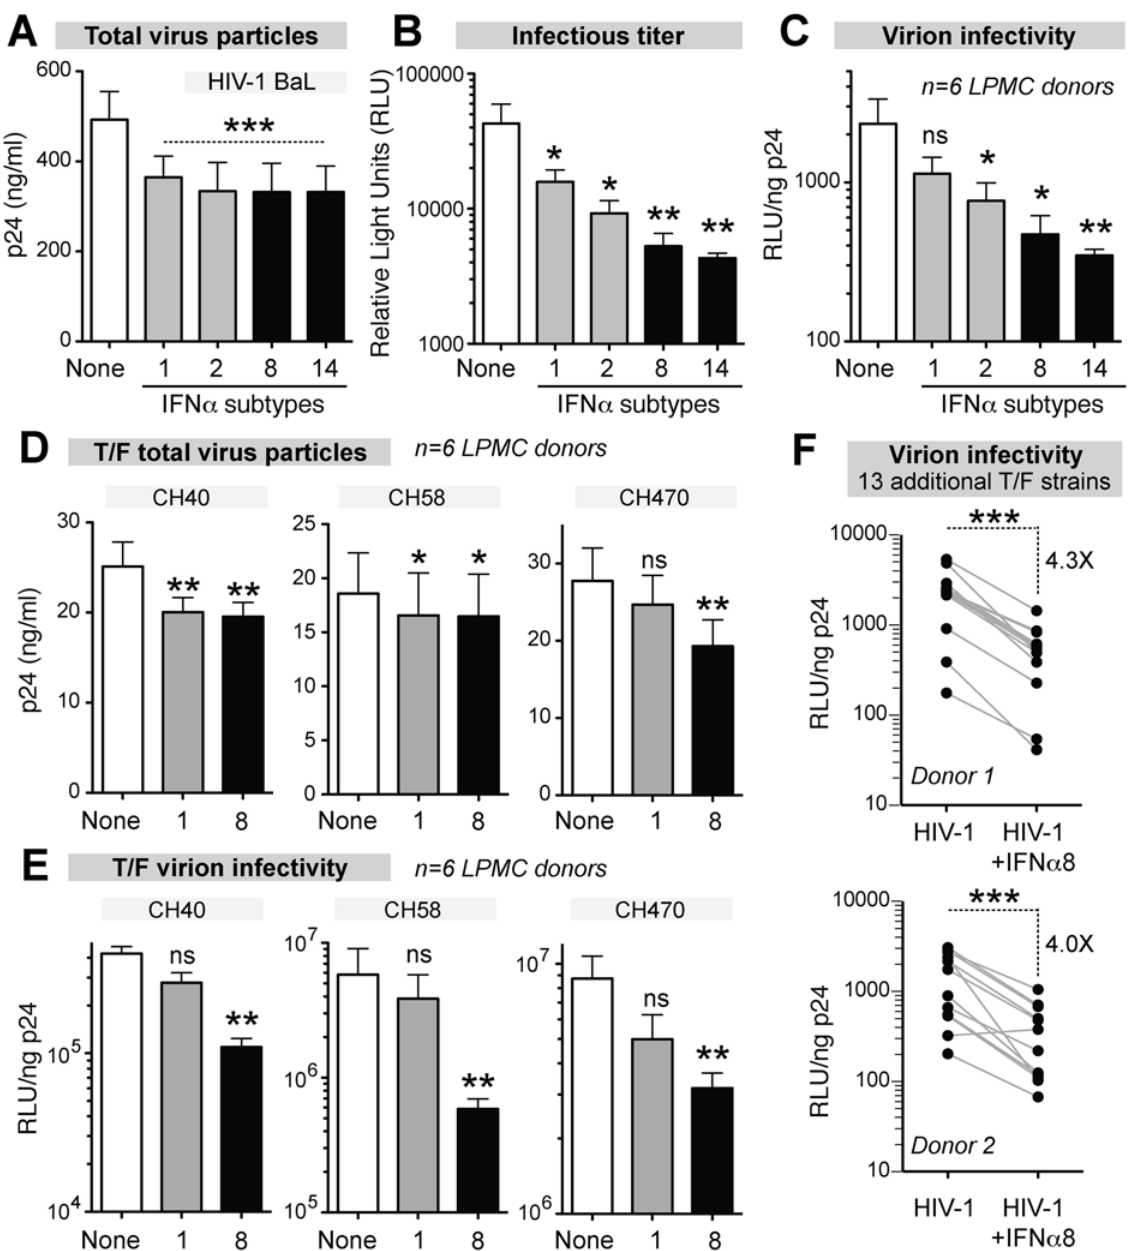
Fig 5. Potent IFN α subtypes inhibit HIV-1 virion infectivity. LPMCs (n = 6 donors) were infected with HIV-1 BaL , treated with IFN α subtypes with weak (gray bars, IFN α 1 and IFN α 2) or strong (black bars, IFN α 8 and IFN α 14) antiviral activity. Supernatants at 4 dpi were evaluated for (A) virus particle titer by p24 ELISA, (B) infectious titer by TZM.bl assay and (C) virion infectivity using the ratio of values from (A) and (B). Similar analyses were performed for HIV-1 T/F strains CH40, CH58 and CH470 with IFN α 1 and IFN α 8, with data on (D) virus particle titer and (e) virion infectivity shown. In (A-E), bars correspond to means with SEM error bars and statistical analyses are shown for comparisons between IFN α -subtype treated samples and no IFN α control ( ‘ none ’ ). Data were analyzed using repeated measures ANOVA with Dunnett ’ s multiple comparison test. In (E), the data were analyzed using Friedman ’ s test to account for non-Gaussian distribution, followed by Dunn ’ s posthoc analysis. (F) Thirteen additional T/F HIV-1 strains (AD17, CH106, CH607, REJO, RHPA, THRO, STCOr1, STCOr2, WARO, MCST, RHGA, TRJO and WITO) were incubated with or without IFN α 8 after infecting LPMCs from 2 donors. At 4 dpi, virion infectivities were computed as in (C) and (E). Each connected line corresponds to a T/F HIV-1 strain. Data were analyzed using a 2-tailed paired Student ’ s t- test. For all panels, ns, not significant at p > 0.05; * , p < 0.05; ** , p < 0.01; *** , p <